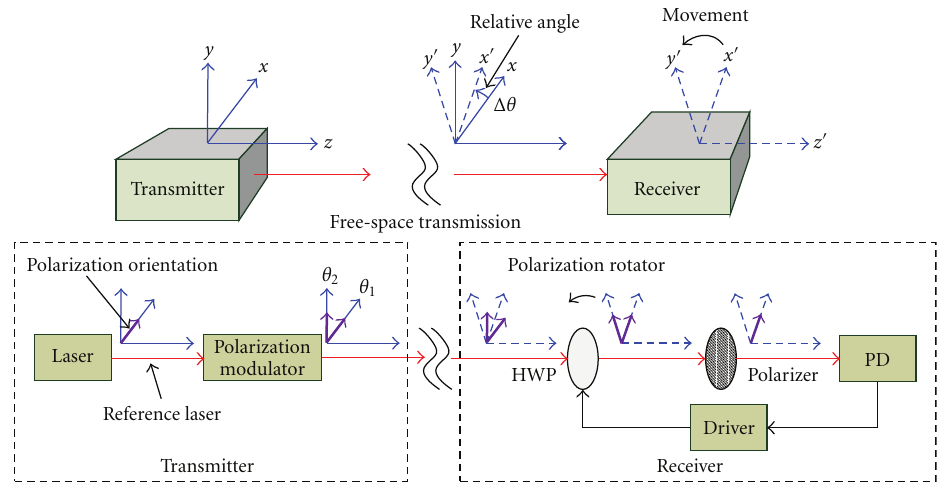
Figure 1: Configuration of the polarization-basis tracking scheme at the